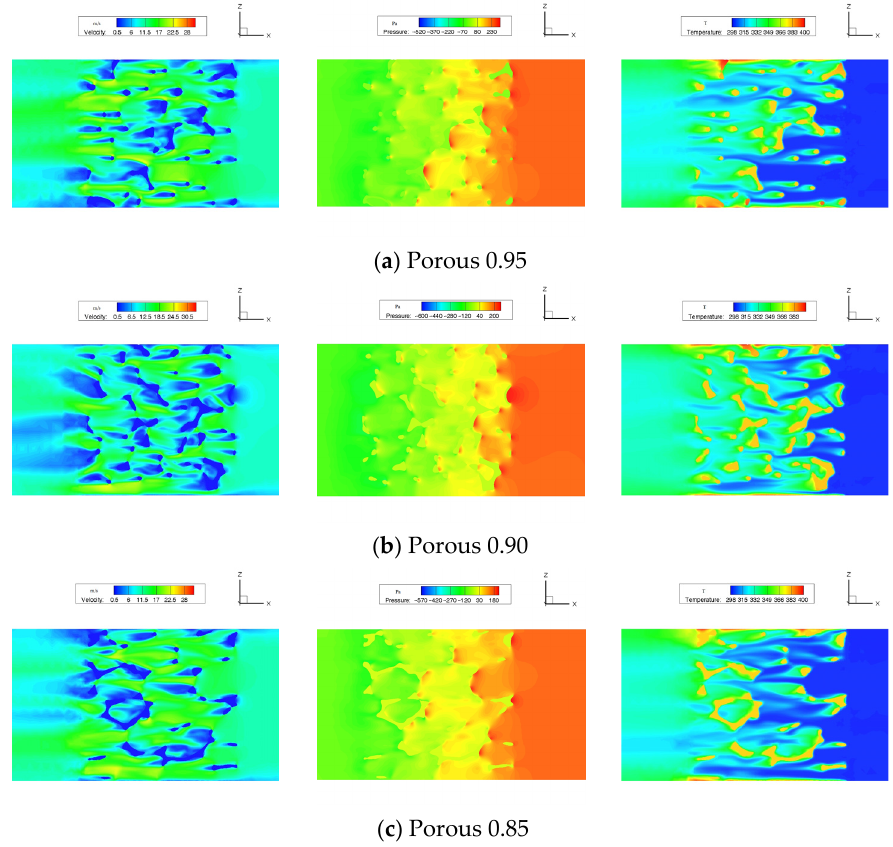
Figure 6. Velocity, pressure and temperature distribution in the middle section of the model.